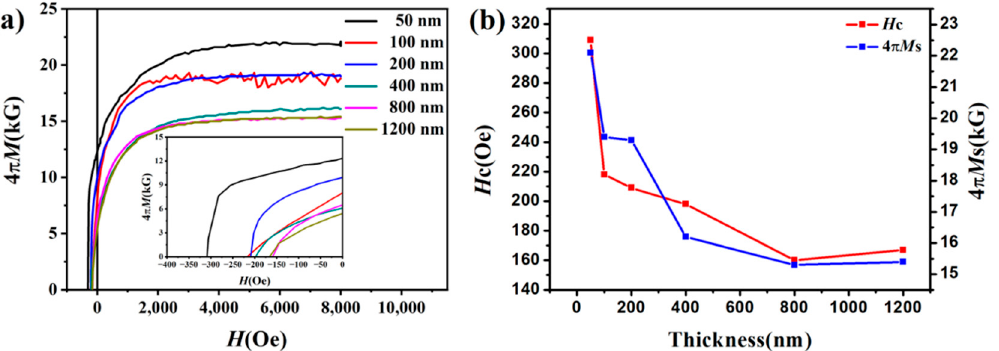
Figure 9. ( a ) Demagnetization curves of FeCo films with different thickness, and ( b ) dependence of the coercivity and saturation magnetization on thicknesses.